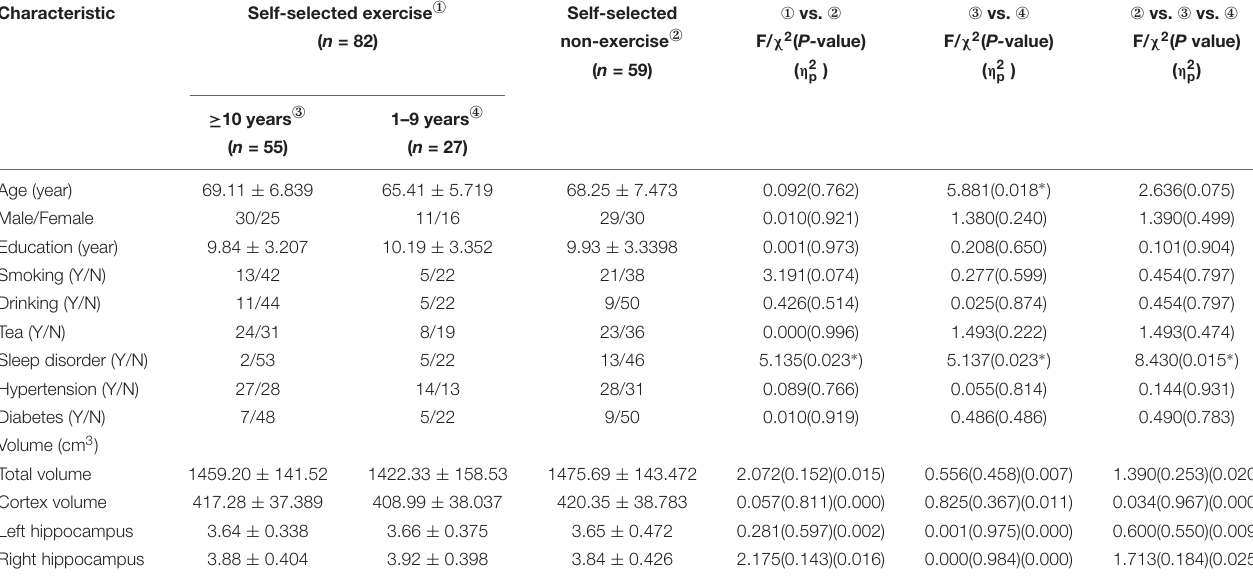
TABLE 3 | Demography, life style, physical diseases, and brain anatomy of study participants in the database subgroup on a non-dementia elderly Chinese population. Characteristic Self-selected exercise (cid:172)